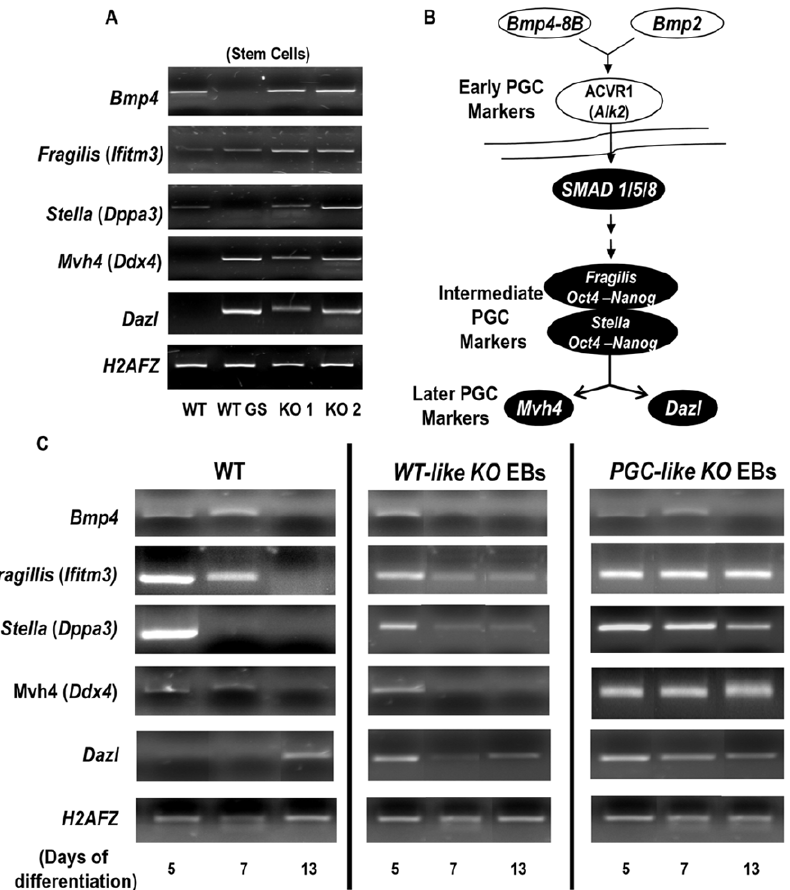
Figure 3. Consequences of Prnp absence in the BMP pathway. A) Detection of PGC markers ( Bmp4, Fragillis, Stella, Mvh4 and Dazl ) in WT ESC, WT GS and the two different Prnp KO ESC lines (KO 1 and KO 2) by PCR. Knock out cells show all the PGC markers analyzed in stem cell state. B) Diagram representing the BMP pathway showing the early, intermediate and later PGC markers (figure adapted from Young et al. 2009). C) Detection of primordial germ cell markers ( Bmp4, Fragillis, Stella, Mvh4 and Dazl ) by PCR during differentiation in WT EBs, WT- like KO EBs and PCG- like KO EBs.